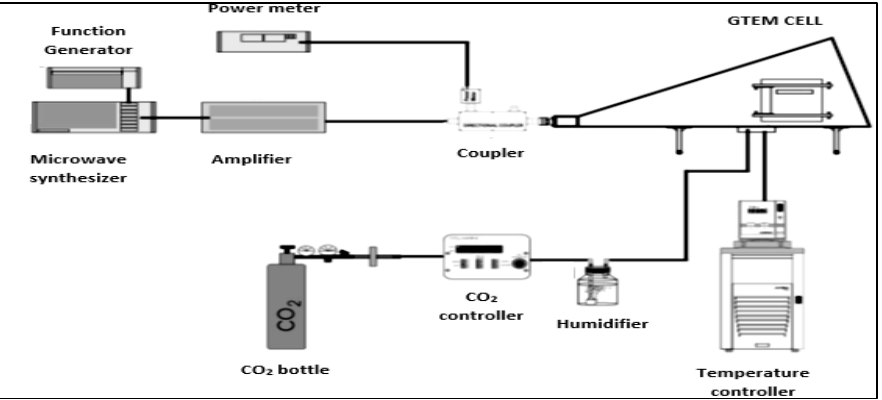
Figure 2. The general scheme of the complete gigahertz transverse electromagnetic (GTEM) assembly.